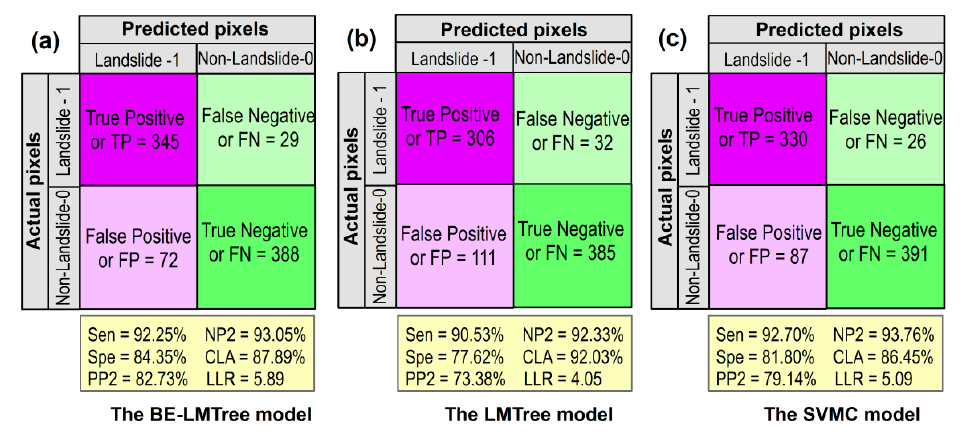
Figure 8 . Confusion matrices and prediction measures of the three landslide models using the validation dataset: ( a ) the BE-LMTree model; ( b ) the LMTree model; and ( c ) the SVMC model.